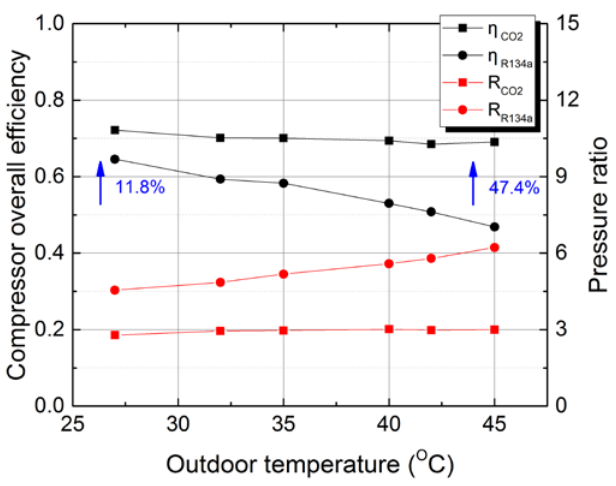
Figure 6. The compressor overall efficiency and pressure ratio at varied outdoor temperature.